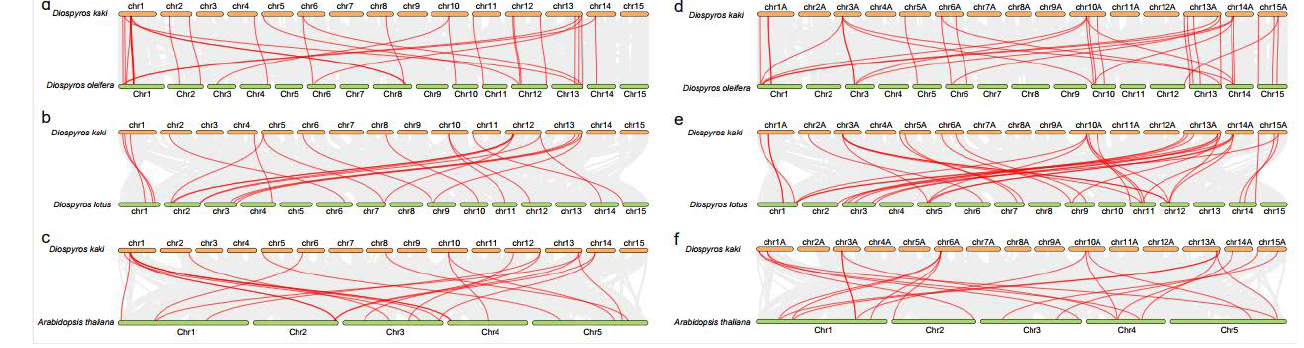
Figure 6. Synteny analysis of PME and PMEI genes between D. kaki , D. oleifera , and D. lotus , and A. thaliana . ( a ) PME genes between D. kaki and D. oleifera . ( b ) PME genes between D. kaki and D. lotus . ( c ) PME genes between D. kaki and A. thaliana . ( d ) PMEI genes between D. kaki and D. oleifera . ( e ) PMEI genes between D. kaki and D. lotus . ( f ) PMEI genes between D. kaki and A. thaliana